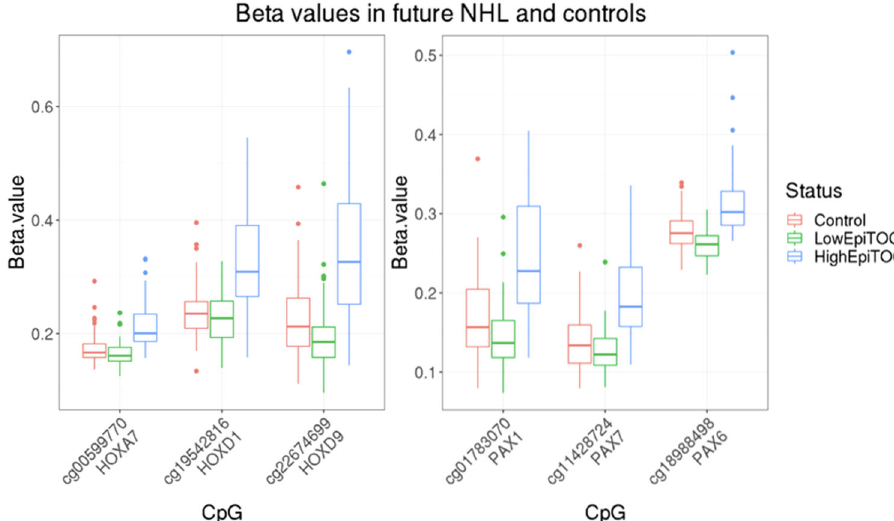
Fig. 2 Top three CpGs corresponding to HOX and PAX genes in the prospective NHL and control groups. List of CpGs corresponding to HOX and PAX genes signi fi cantly hyper-methylated in the group with high epiTOC estimated levels (cg00599770 P = 1.34 × 10 − 9 , cg19542816 P = 4.10 × 10 − 8 , cg22674699 P = 1.22 × 10 − 7 , cg01783070 P = 2.43 × 10 − 8 , cg11428724 P = 3.75 × 10 − 8 , cg18988498 P = 3.32 × 10 − 8 ) identi fi ed using univariate regression analyses ( N = 278). The box plot uses the median (horizontal line), the fi rst and third quartiles (ends of box) and points more than 3/2 times the interquartile range